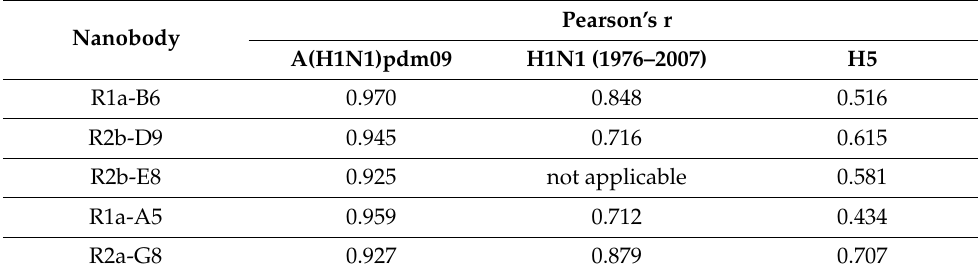
Table 2. Correlation between estimated and assigned